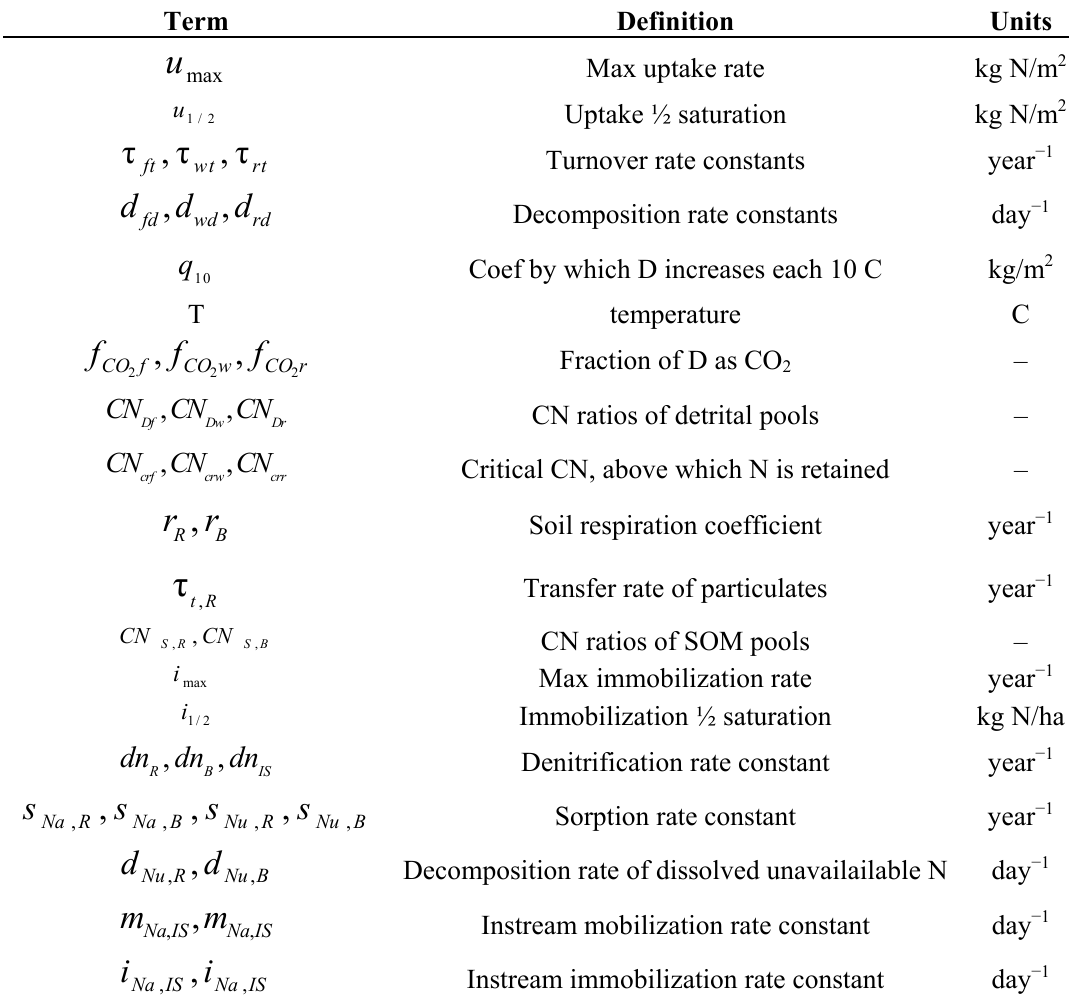
Table 8. Parameters and auxiliary equations completing the soil, aquatic, and hydrologic portions of the